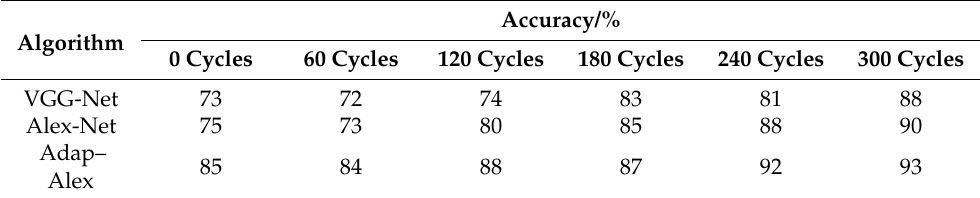
Table 7. Recognition accuracies of the three network